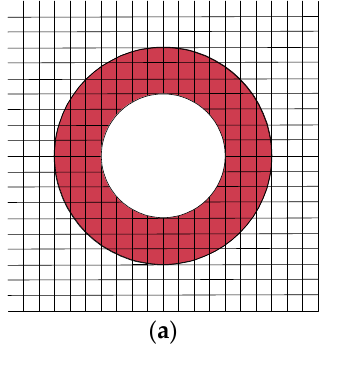
Figure 1. Grid dissection of the circular structure: ( a ) Actual grid dissection of a circular structure; ( b ) Grid dissection of circular structure by ladder approximation method; ( c ) Dissection of circular structure by conformal grid technology.